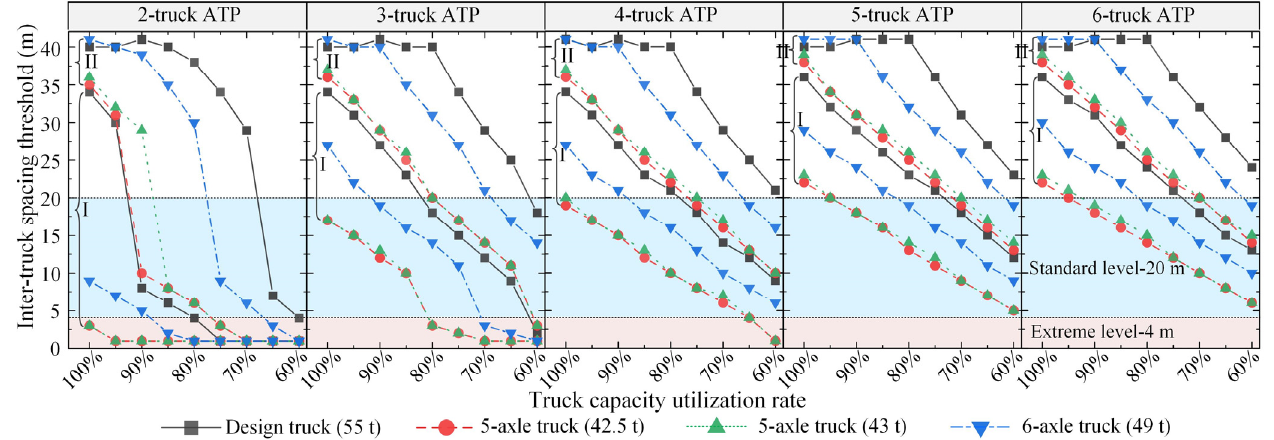
Figure 13. Inter-truck spacing thresholds for ATP crossing continuous bridges with different truck capacity utilization rates and different platooning sizes. Table 3. Suggested upper mass limits (t) for platooning trucks crossing continuous